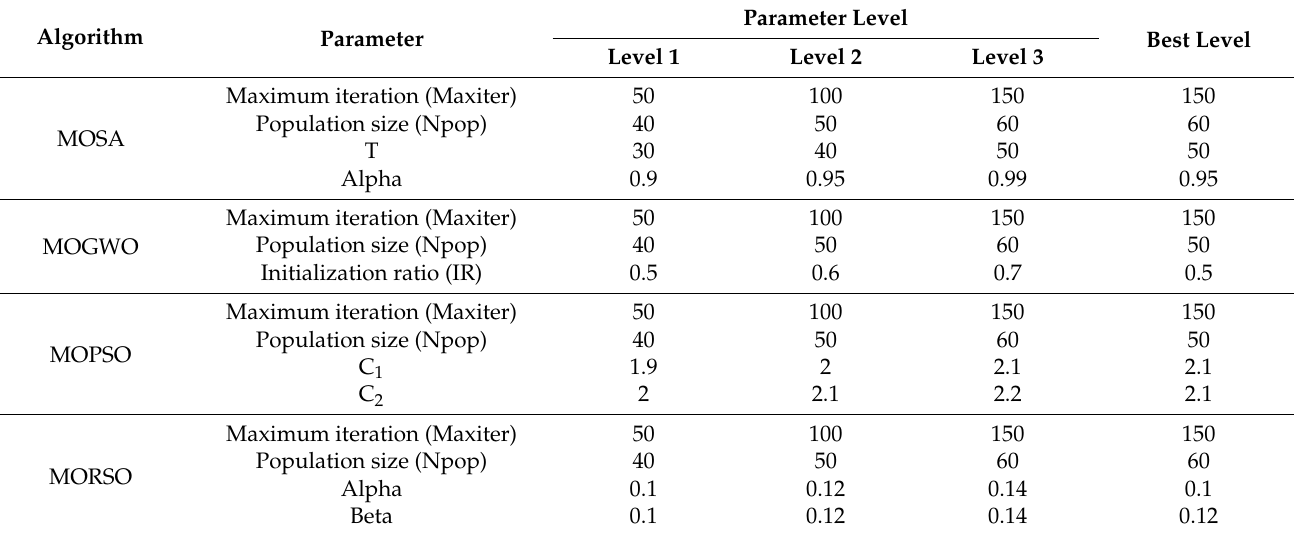
Table 5. Applied algorithms’ parameter levels and their values.